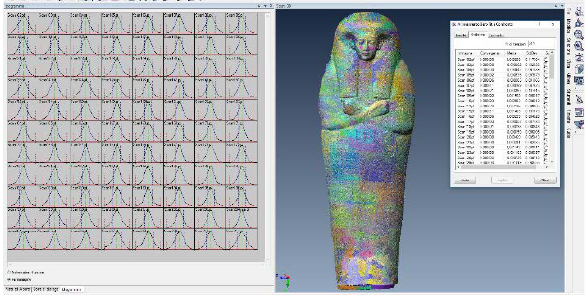
Figure 6. The 81 scans